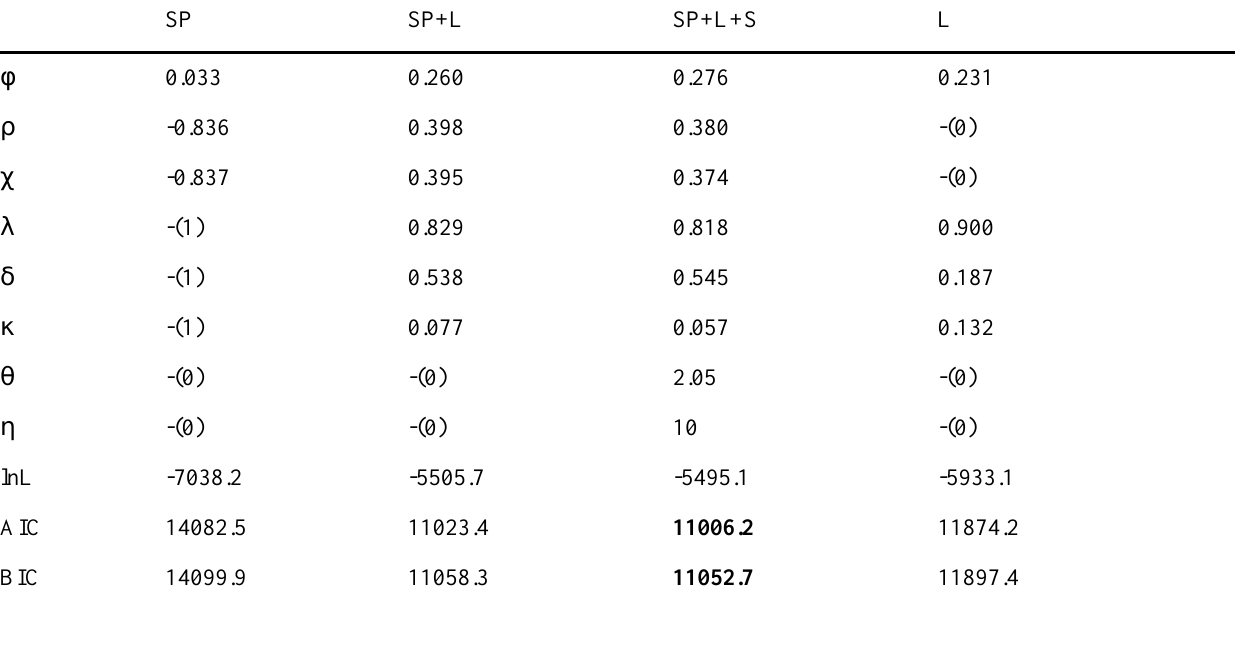
Table 3 . Estimated parameter values for different model versions using the data from experiments with 10 rounds. The model versions are defined as follows: SP = probabilistic choice with social preferences, without learning and signaling; SP+L = probabilistic choice with social preferences with learning and without signaling; SP+L+S = probabilistic choice with social preferences with learning and with signaling; and L = probabilistic choice of income maximizers with learning and without signaling. See Table 2 for a list of parameters and their definitions. InL stands for maximum likelihood, AIC for Akaike Information Criterion, and BIC for Bayesian Information